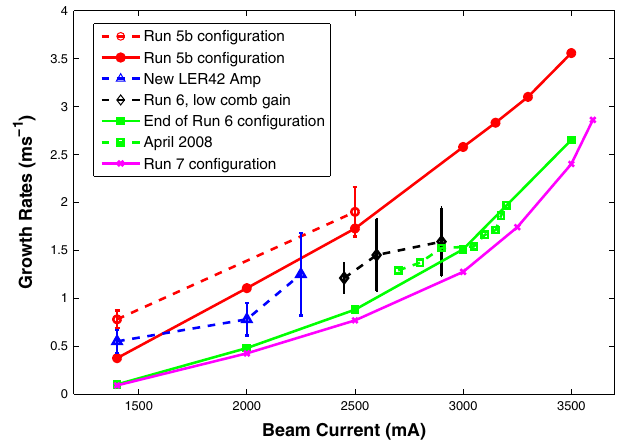
FIG. 24. (Color) Modeled (solid) and measured (dashed) LER low-mode instability growth rates for various operating configu- rations. The 30% reduction in cavity fundamental-driven growth rates from run 5 through to run 6 is due to replacing nonlinear drive amps and implementing comb rotation configurations. Error bars are not included for the April 2008 data because they crowd the image. They are comparable in magnitude with the error bars from the run 6 data. The final LER configuration developed (run 7) was estimated to allow 3600 mA operation in the LER.